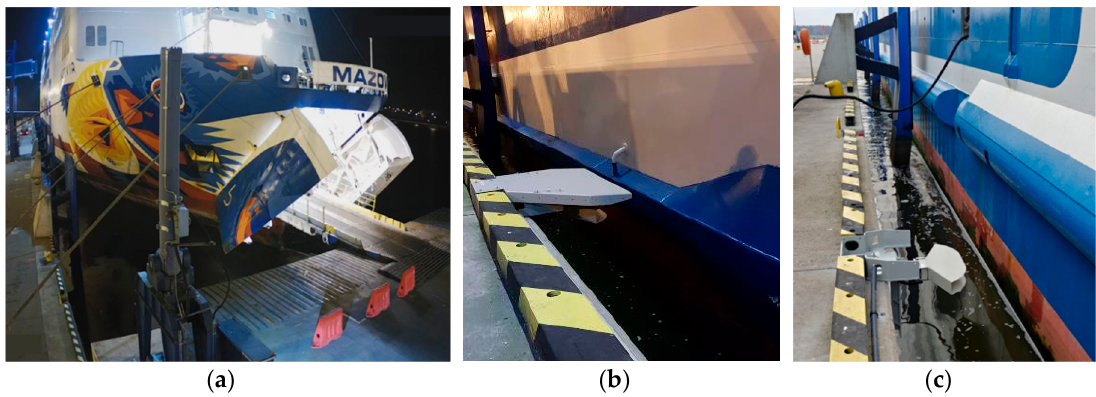
Figure 14. Location of the m/f Mazovia bow in relation to the ramp during cargo operations on Ferry post no 1 ( a ). Location of the m/f Mazovia side in relation to the berth. Laser scanner, shore fender and ship’s bumper are visible. The system reports correct distance between the ship and fenders ( b ). Location of the m/f Cracovia side in relations to the berth. Laser scanner, shore fender and ship’s bumper are visible. The system reports incorrect distance between the ship and fenders ( c ).